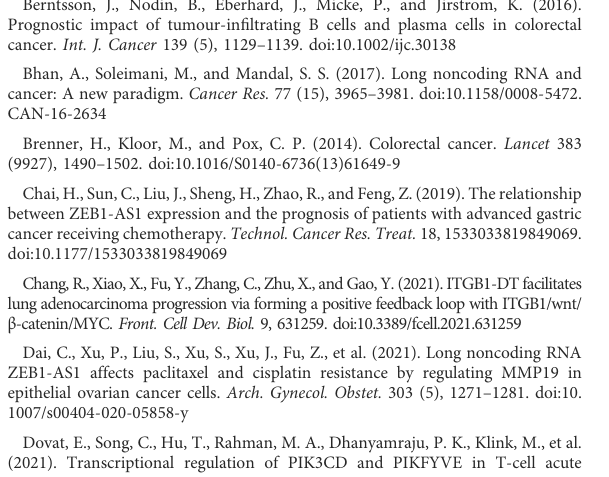
SUPPLEMENTARY FIGURE S2 TheGeneSetEnrichmentAnalysis(GSEA)betweentwoclustersbasedon 28 m6A-related prognostic lncRNAs.